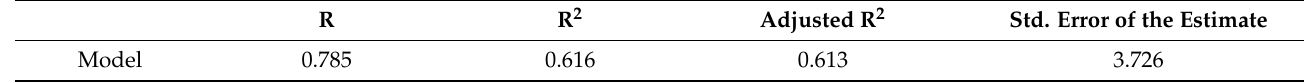
Table 2. Multiple linear regression model.